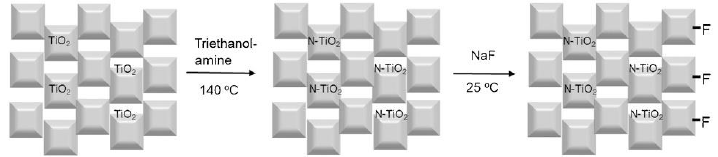
Figure 12. Proposed synthetic route toward N, F-codoped anatase TiO 2 mesocrystals. Reprinted with permission from [158]. Copyright Elsevier, 2016.